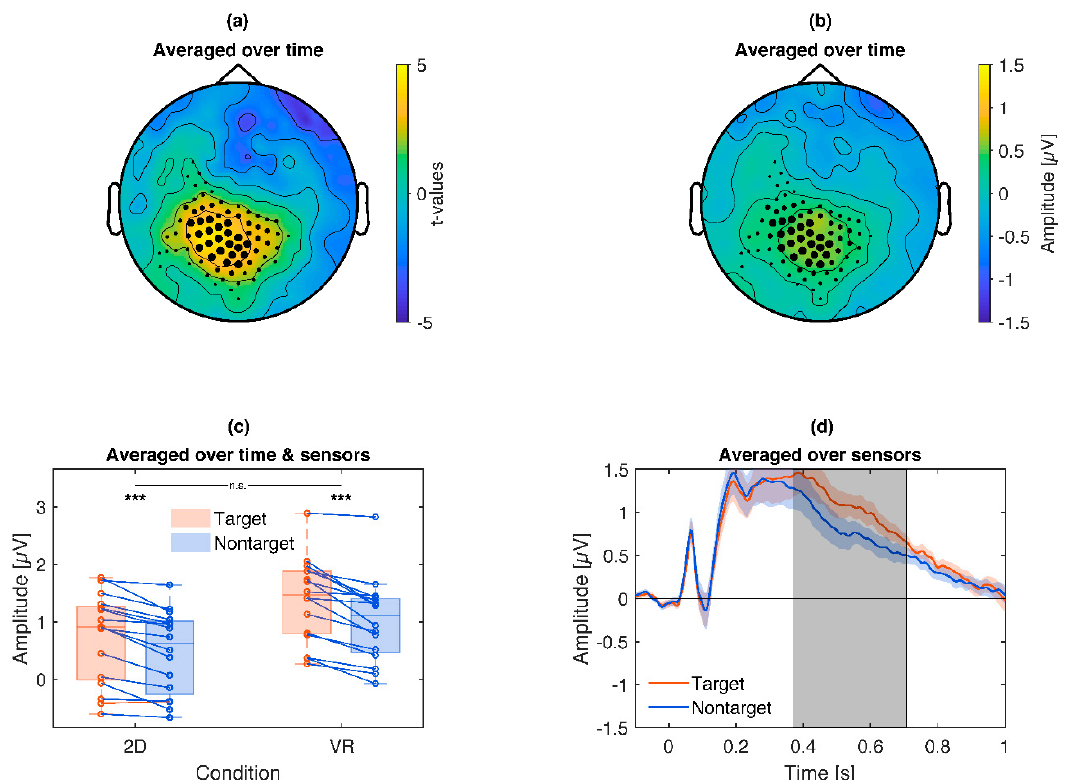
Figure 9. Illustration of the target P3 cluster: Target pictures lead to an enhanced P3 compared to nontarget pictures. (a): Topography of t -values averaged across the significant time points. (b): Topography of the scalp potential difference. (c): Box plot and single subject values from the cluster. Blue lines indicate a more positive P3 for target compared to nontarget pictures, red the opposite. Asterisks illustrate the significance of exploratory post-hoc subgroup comparisons: *** p < 0.001, ns p > 0.05. (d): Time course of the respective P3 cluster. Colored shaded areas signify standard errors. Grey shaded areas signify the latency of the cluster.